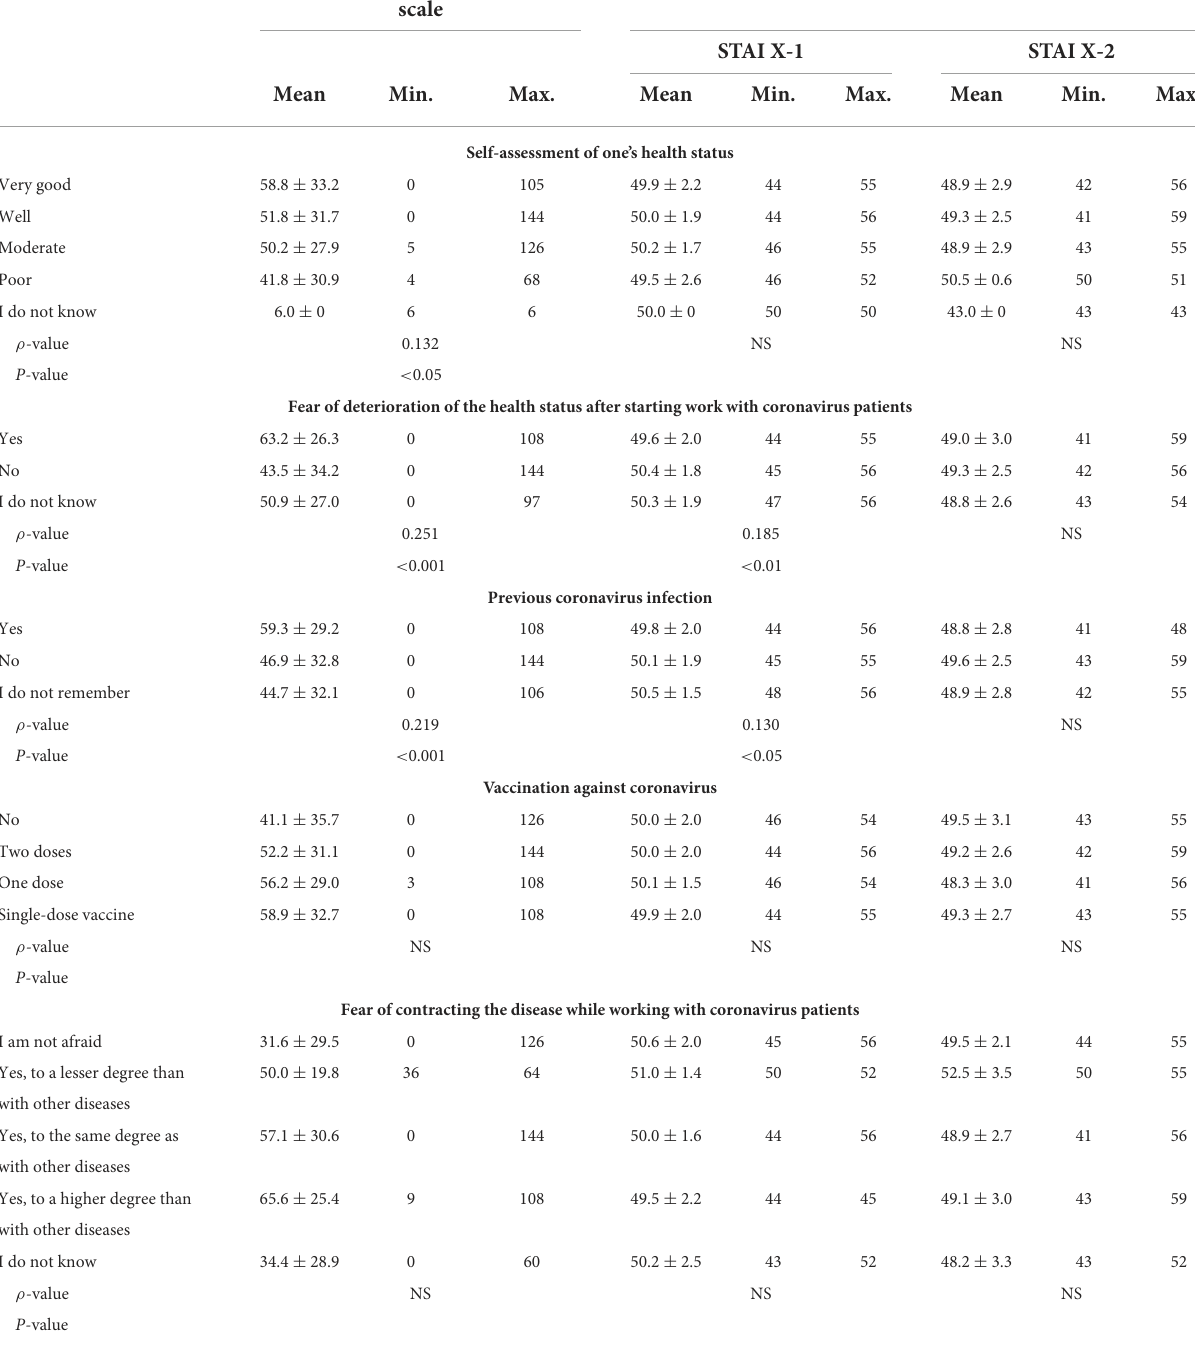
TABLE 5 Level of social anxiety, state anxiety (X-1) or trait anxiety (X-2) and self-perceived health status, fear of health deterioration after starting work with coronavirus patients, having had a coronavirus infection, having received coronavirus vaccination and fear of contracting the disease while working with coronavirus